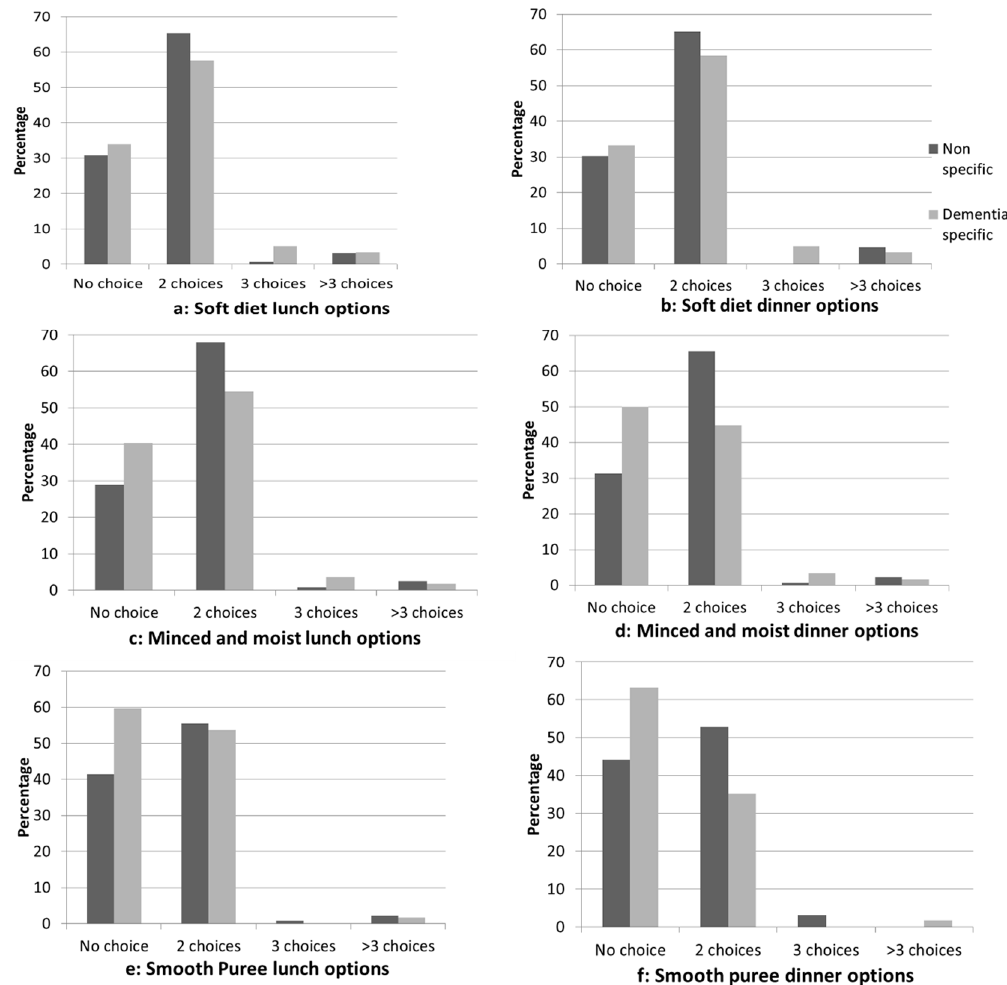
Figure 1. Comparison of the number of choices for texture modified diets in dementia-specific and nonspecific facilities.